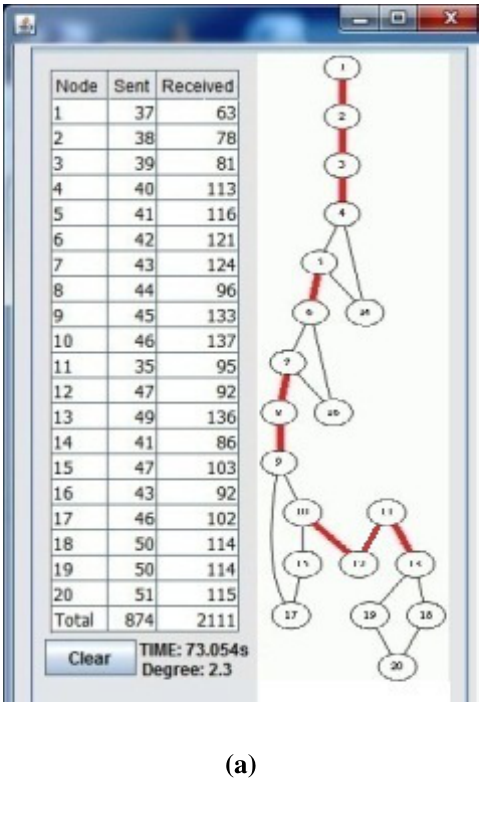
Figure 11. Snapshot of the monitoring program and deployment for the caterpillar